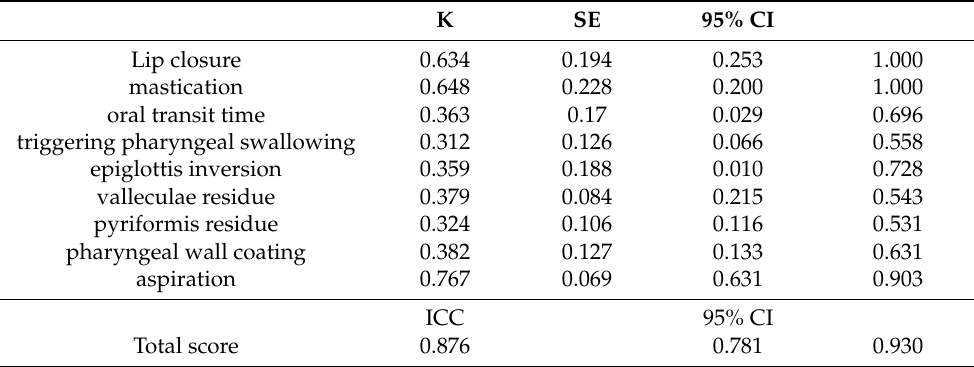
Table 4. Inter-reliability of modified videofluoroscopic dysphaga scale (mVDS).